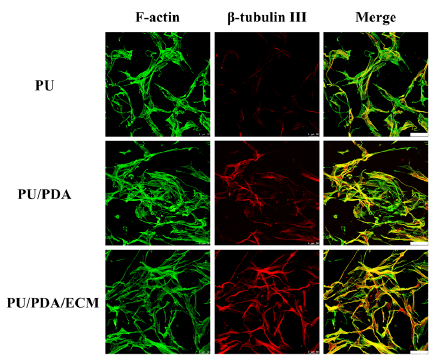
group. “*” indicates a significant difference ( p < 0.05) when compared to PU conduit.